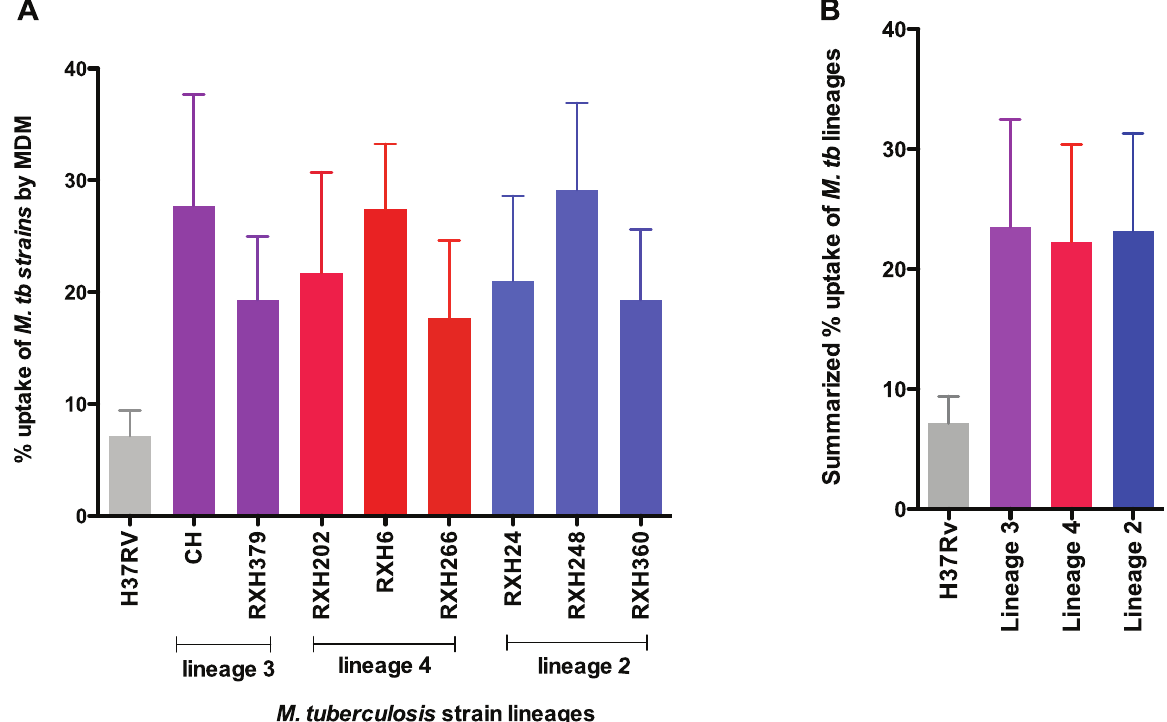
Figure 2. Strain uptake by monocyte derived macrophages. Fig. 2 (A) Uptake of M. tuberculosis strains by MDM (4 h CFU calculated as a percentage of initial inoculum). Fig. 2 ( B ) Summarized uptake of M. tuberculosis strain lineages by MDM. H37Rv showed significantly lower uptake by the than clinical strains # (p , 0.001). Data represent the mean 6 SD (n=7). doi:10.1371/journal.pone.0043170.g002 PLOS ONE |